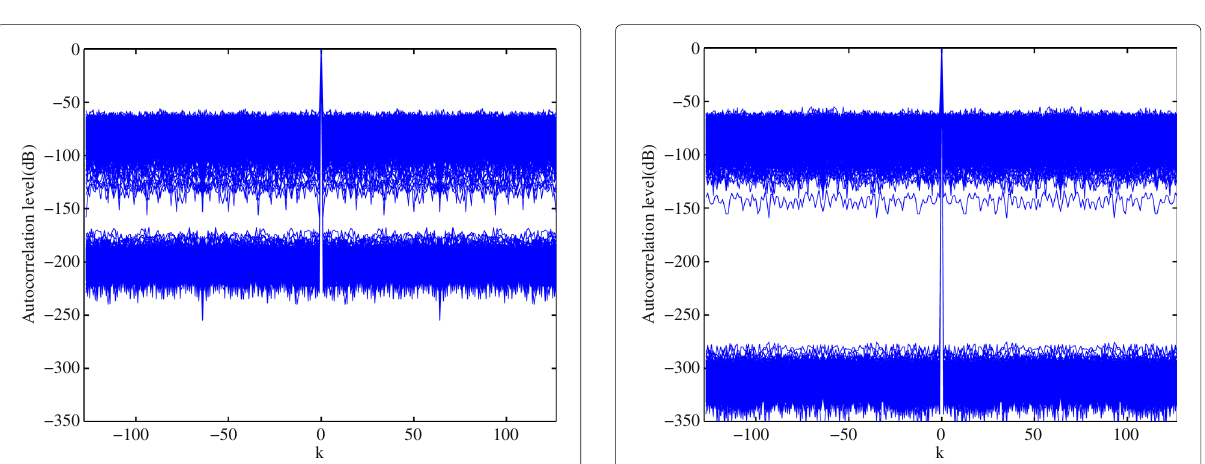
Fig. 3 Autocorrelation level of the sequences generated by